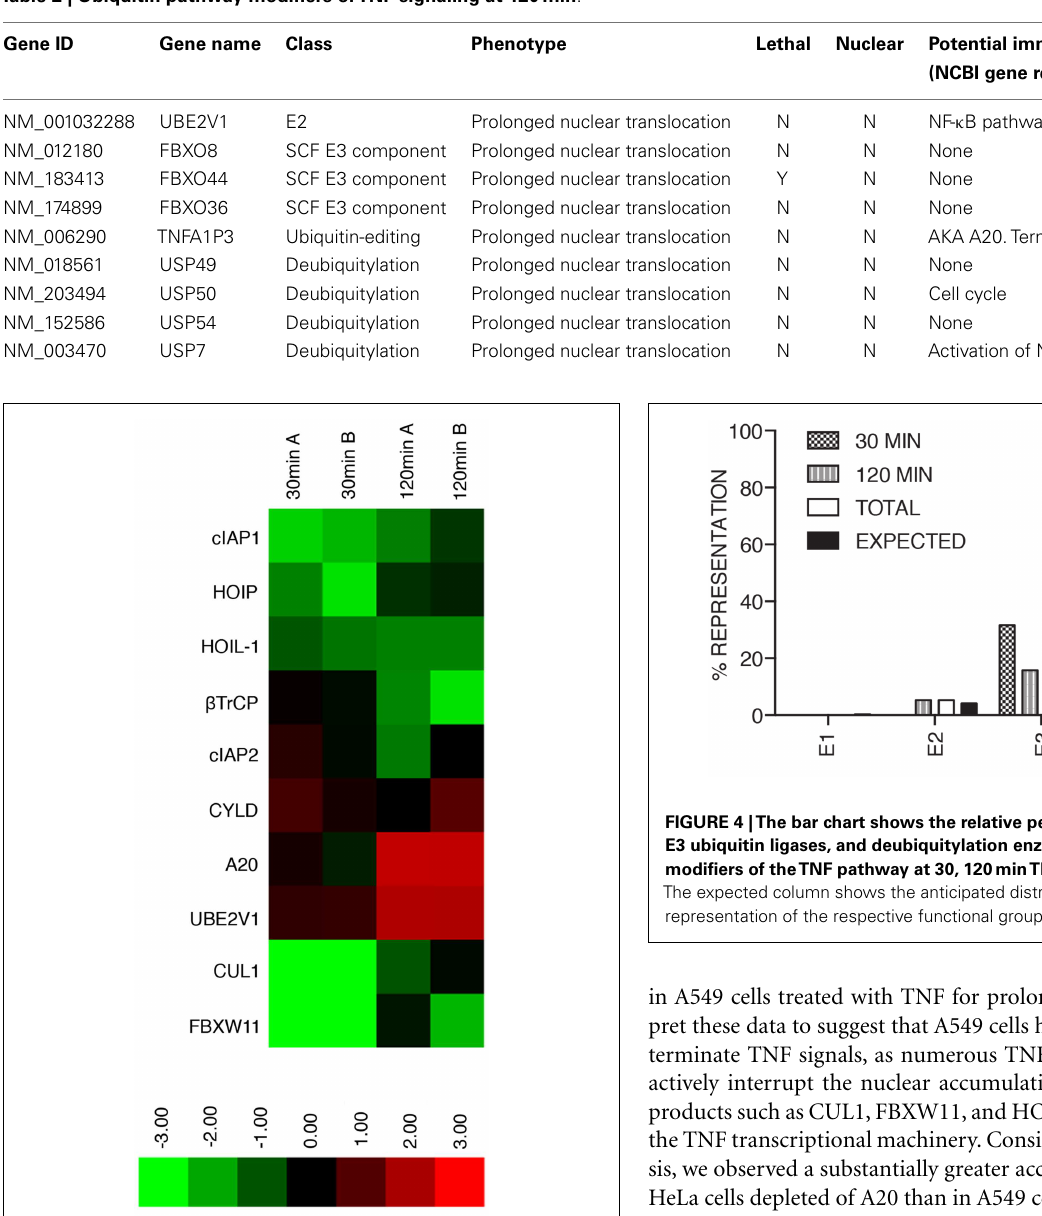
Table 2 | Ubiquitin pathway modifiers ofTNF signaling at 120min .